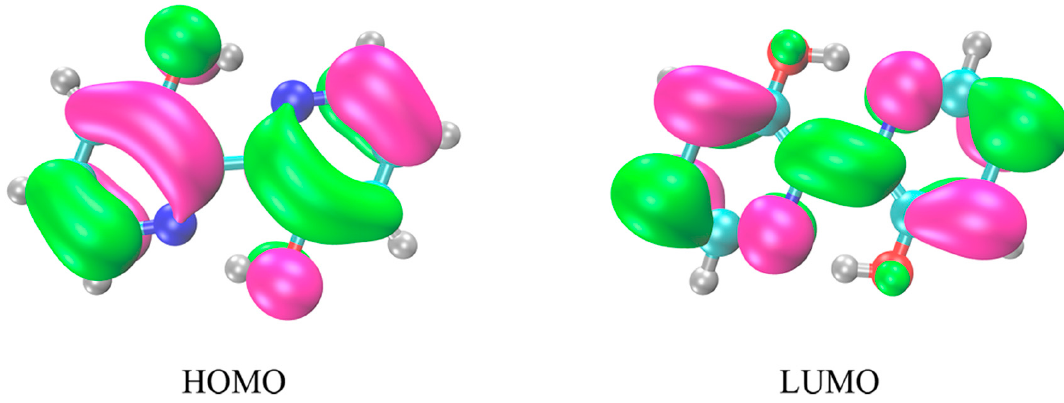
Figure 2. The HOMO and LUMO of BP(OH) 2 in hexane solvent.